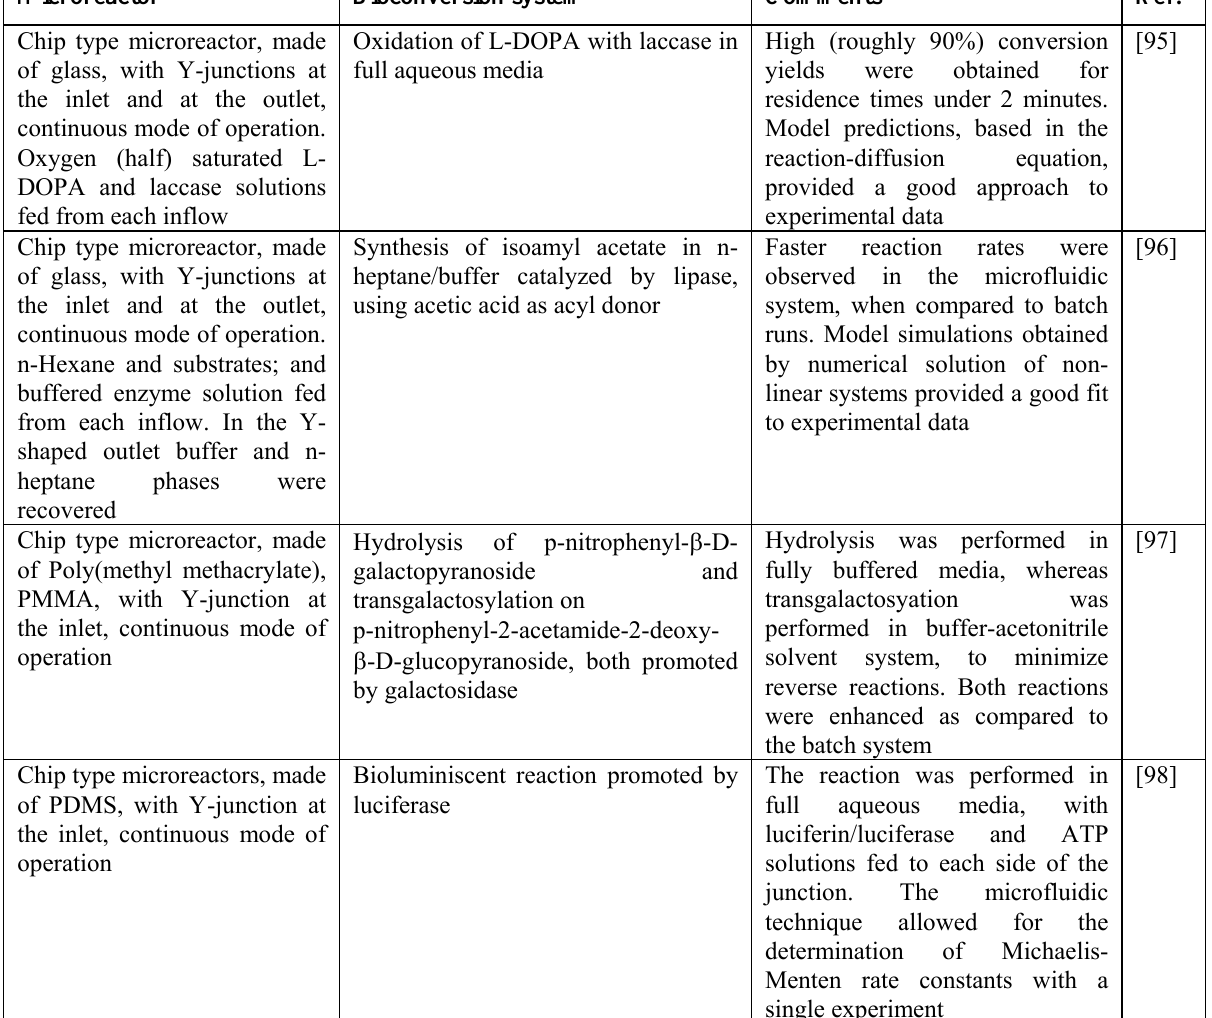
Table 3. Examples of microfluidic systems for enzyme catalysis in liquid